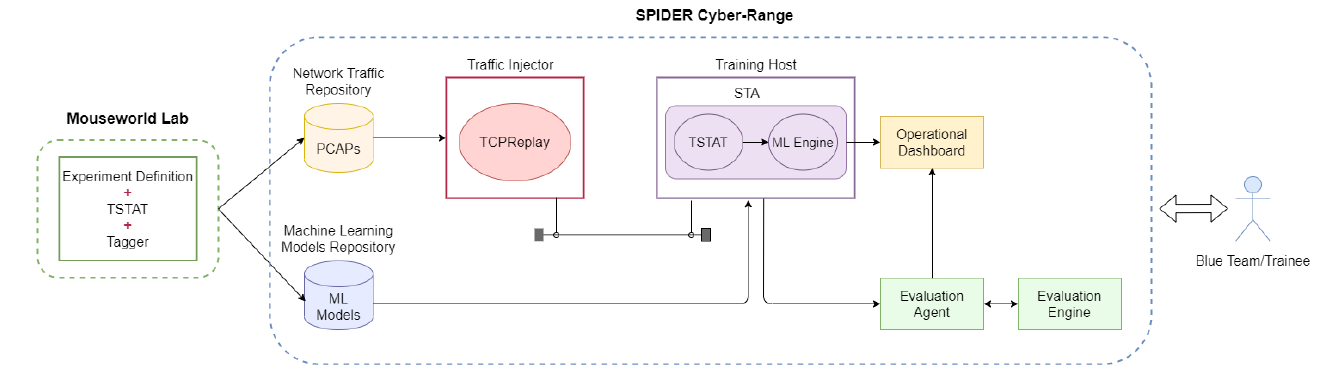
Figure 1. Integration of ML-based attack detectors in SPIDER defensive blue team